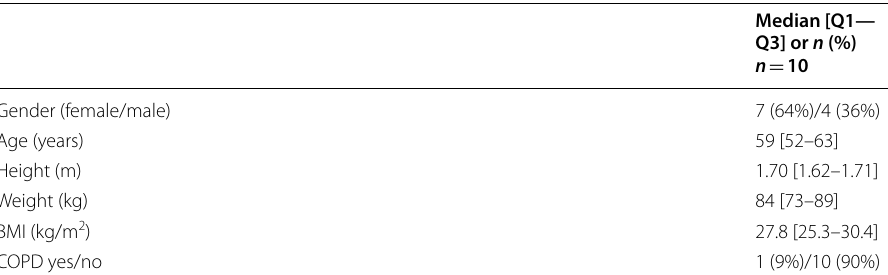
n 10. Continuous variables are summarised as median [25th percentile–75th percentile]. Discrete variables are presented = as counts (percentage) F female, M male, BMI body mass index, COPD chronic obstructive pulmonary